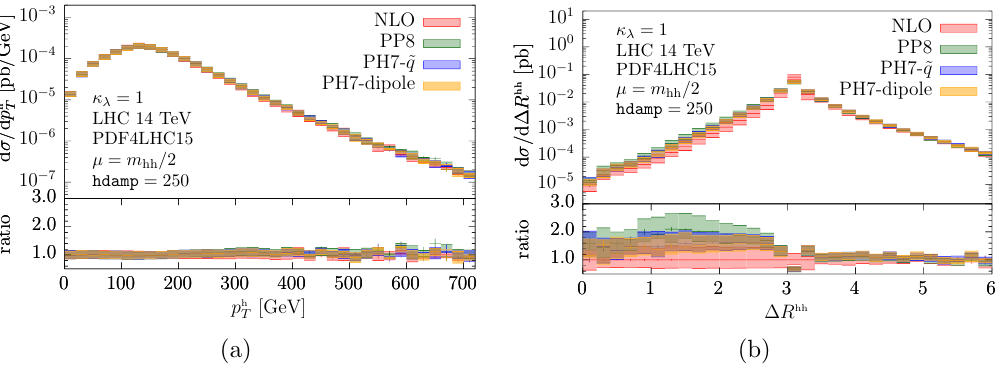
Figure 5. The transverse momentum of one (any) Higgs boson and the R -separation between the two Higgs bosons are shown for the (cid:12)xed-order NLO calculation and three shower setups, in the (cid:20) (cid:21) = 1